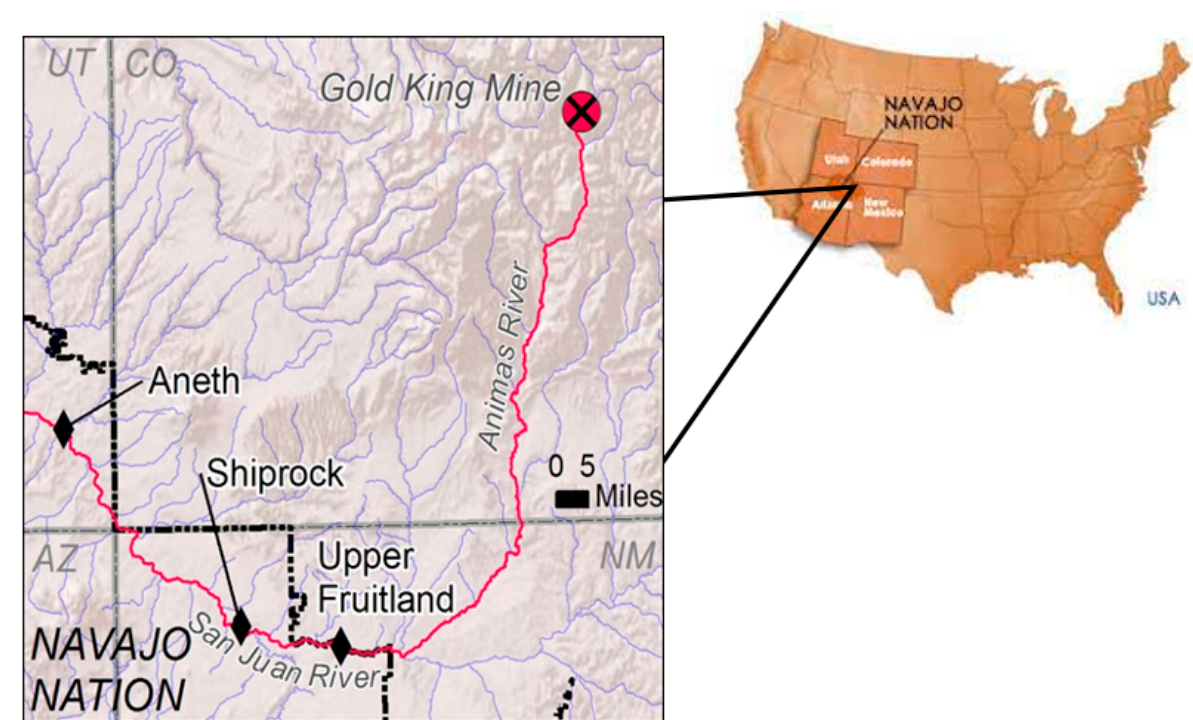
Figure 1. Map illustrating the location of Gold King Mine and Diné communities [24].